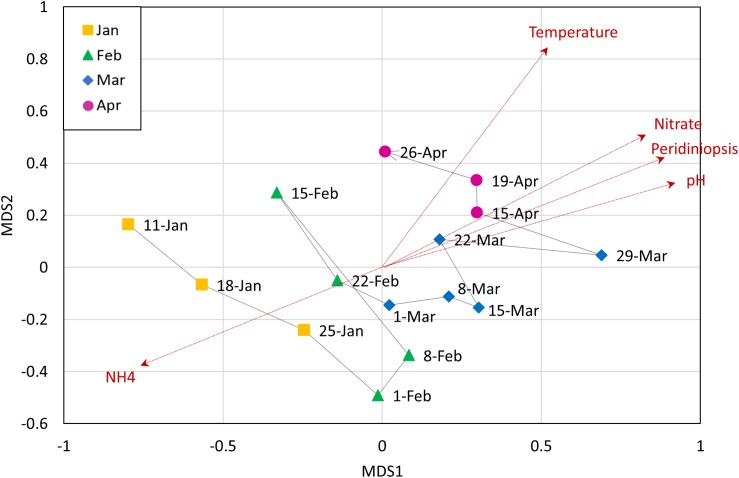
Non-metric multidimensional scaling (NMDS) analysis of heterotrophic community composition of data from OTU abundance, with corresponding environmental variables. Analysis was based on Bray-Curtis dissimilarities. Vectors are environmental variables that were found to be significantly affecting the distribution of the points (dashed red arrows). The line connecting the data points represents the temporal change in the community.